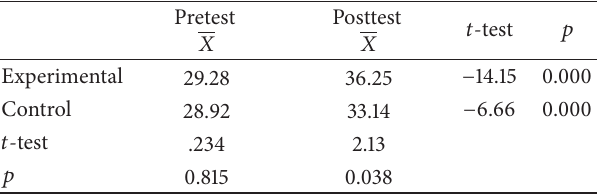
Table 7: Summary of academic achievement scores.